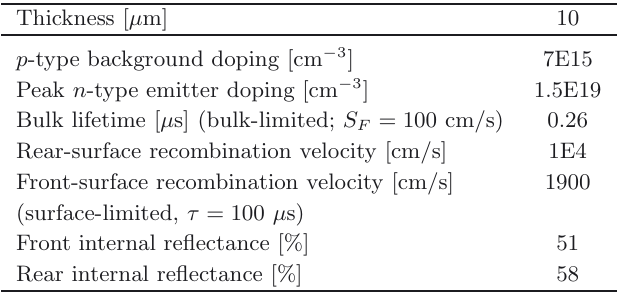
Table 1. PC1D model parameters.